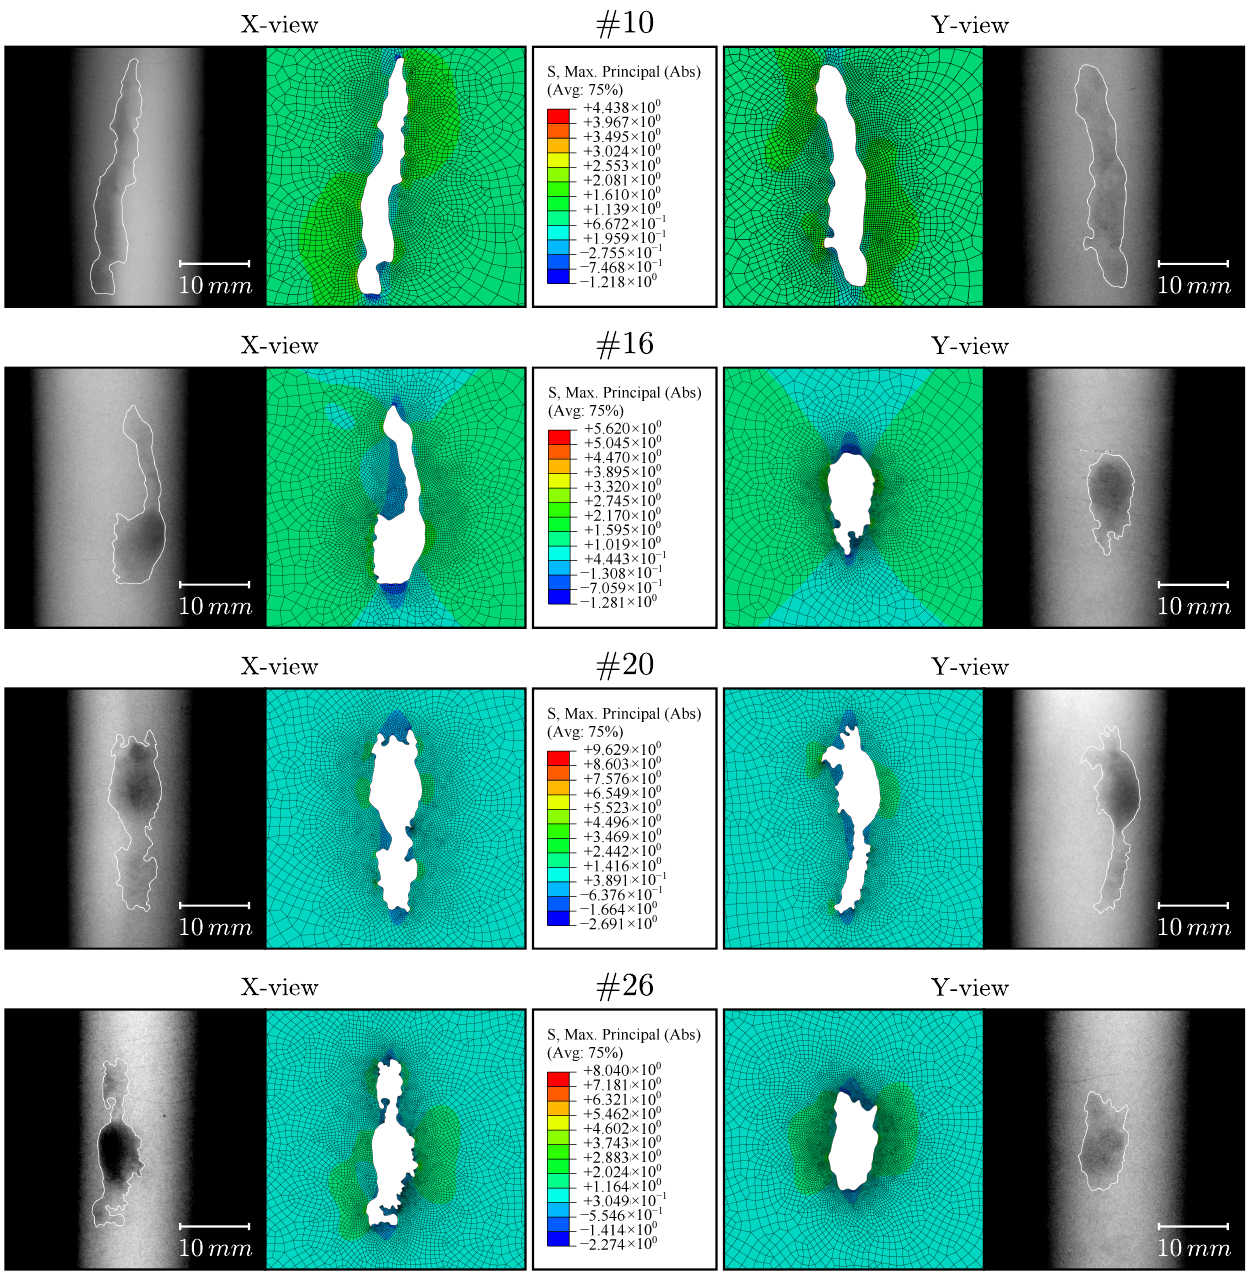
Figure 9. Numerical results based on the radiographs of specimens #10, #16, #20 and